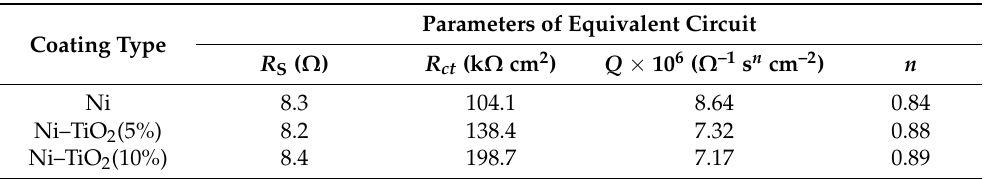
Table 2. Parameters of equivalent circuit calculated according to the adopted equivalent circuit for corrosion of nickel and nickel–titania electrodeposited films in a 3% NaCl water solution at 298